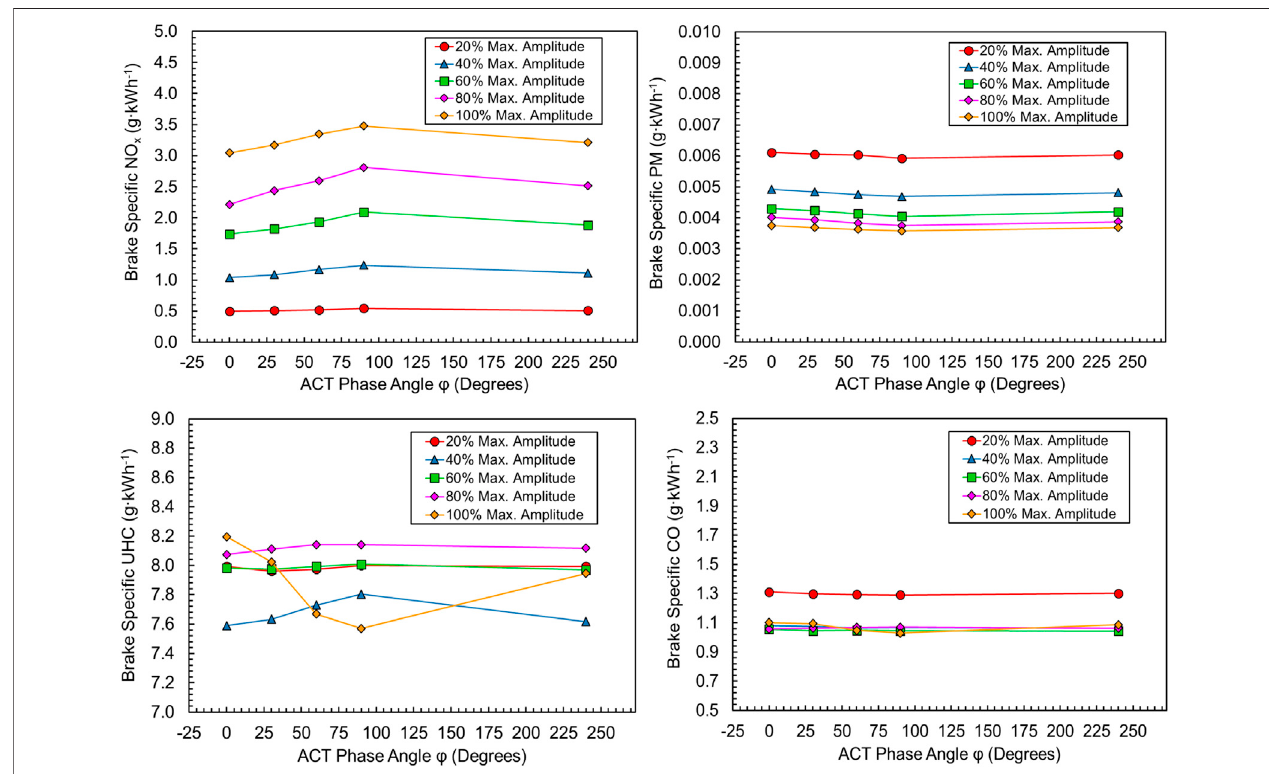
FIGURE 14 | Impact of amplitude ratio and phase angle on (top, left) : NO x emissions, (top, right) : soot emissions, (bottom, left) : unburnt hydrocarbon emissions, and (bottom, right) : carbon monoxide emissions.